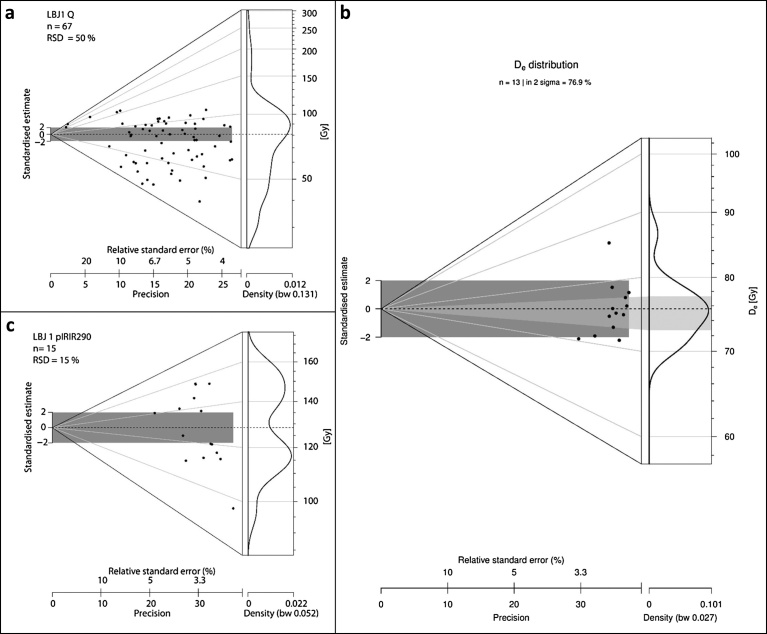
La Boja OSL dating. Representative equivalent dose distributions of the dated quartz and feldspar samples. The distributions, displayed as abanico plots (Dietze et al., 2016), which combine a scatter plot with a kernel density estimate, are for sample C-L3901, taken at the base of the sequence, immediately below OH23. The dashed line is the arithmetic mean equivalent dose. The plots were generated using R Luminescence package version 0.7.3 (Dietze and Kreutzer, 2017). a. quartz. b. feldspar (IR50). c. feldspar (pIRIR290).